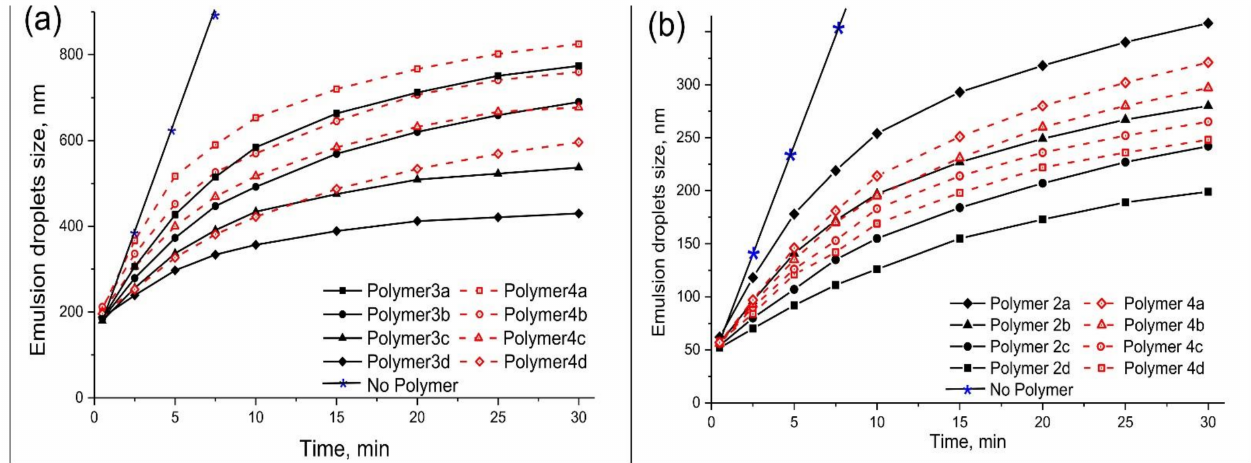
Figure 10. Change of the droplet sizes of emulsions stabilized by silatrane polymers. ( a ) direct emulsions, ( b ) reverse emulsions. Curve * not stabilized